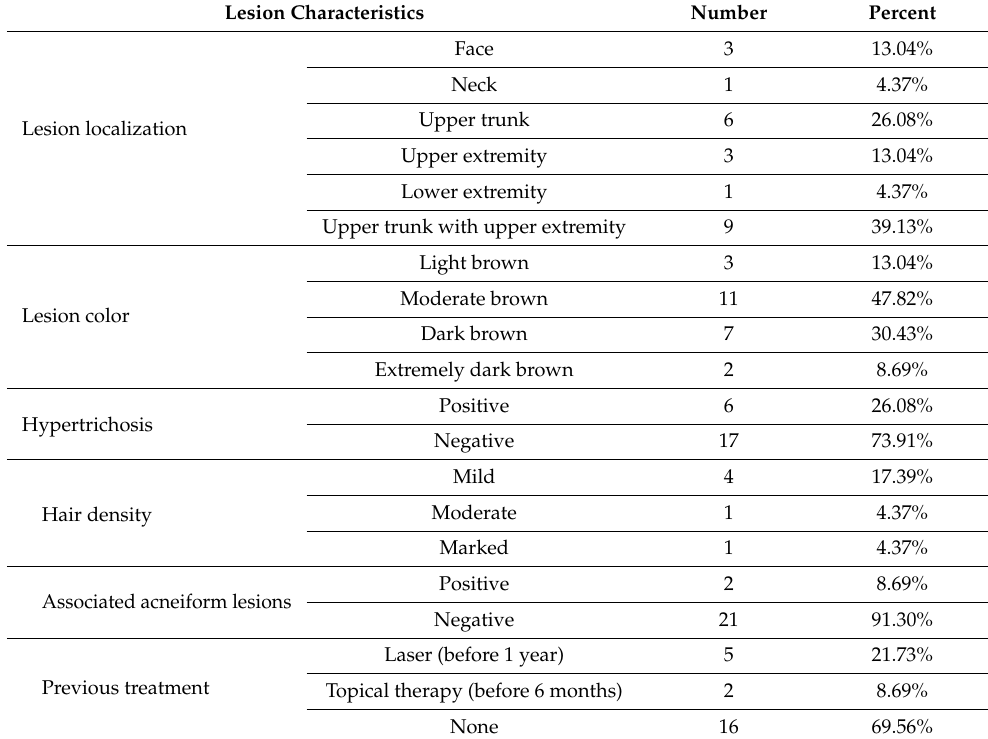
Table 2. Lesion characteristics of the studied